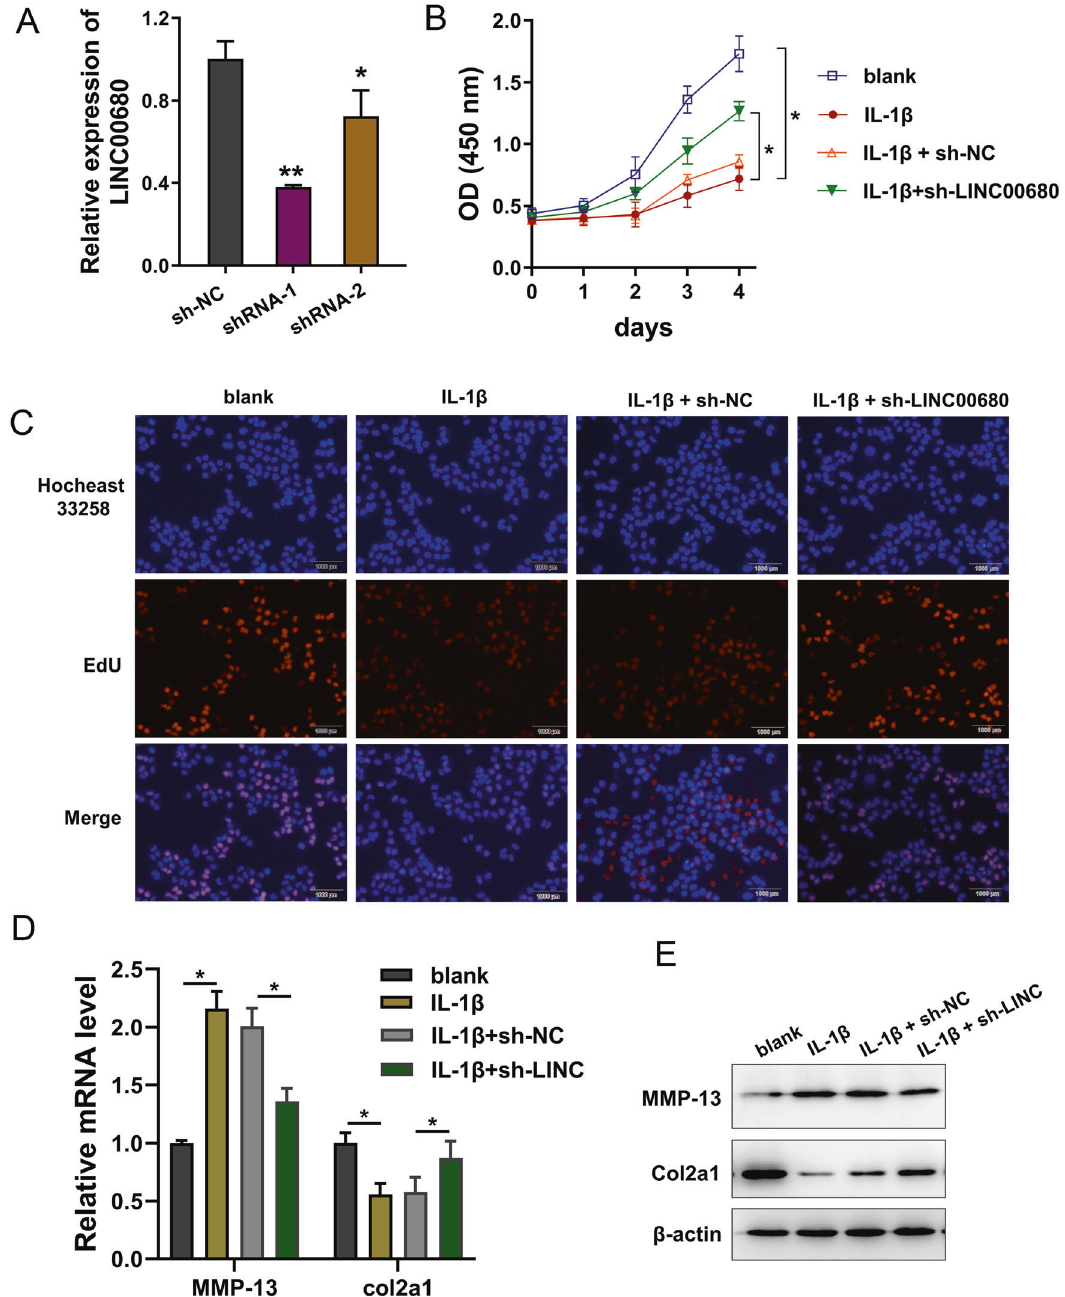
Fig. 3 Knockdown of LINC00680 repressed the proliferation and ECM degradation. A LINC00680 knockdown (sh-LINC00680) was transfected into chondrocytes treated with IL-1 β (10 ng/ml). RT-qPCR detected the level of LINC00680 upon sh-LINC00680 trasnfection. B CCK- 8 proliferation assay detected the absorbance (450 nm) of chondrocytes treated with IL-1 β and/or sh-LINC00680/sh-NC. C EdU (5 ′ -ethynyl-2 ′ - deoxyuridine) assay was performed for the proliferation of chondrocytes. EdU-positive cells and total Hoechst33258-positive cells were shown. D RT-PCR detected the mRNA levels of MMP-13 and Col2a1 in chondrocytes treated with IL-1 β and/or sh-LINC00680/sh-NC. E Western blot analysis detected the MMP-13 protein and Col2a1 protein levels. Experiments ’ data were repeated in triplicate. *Indicates the p < 0.05, and **Indicates the p <